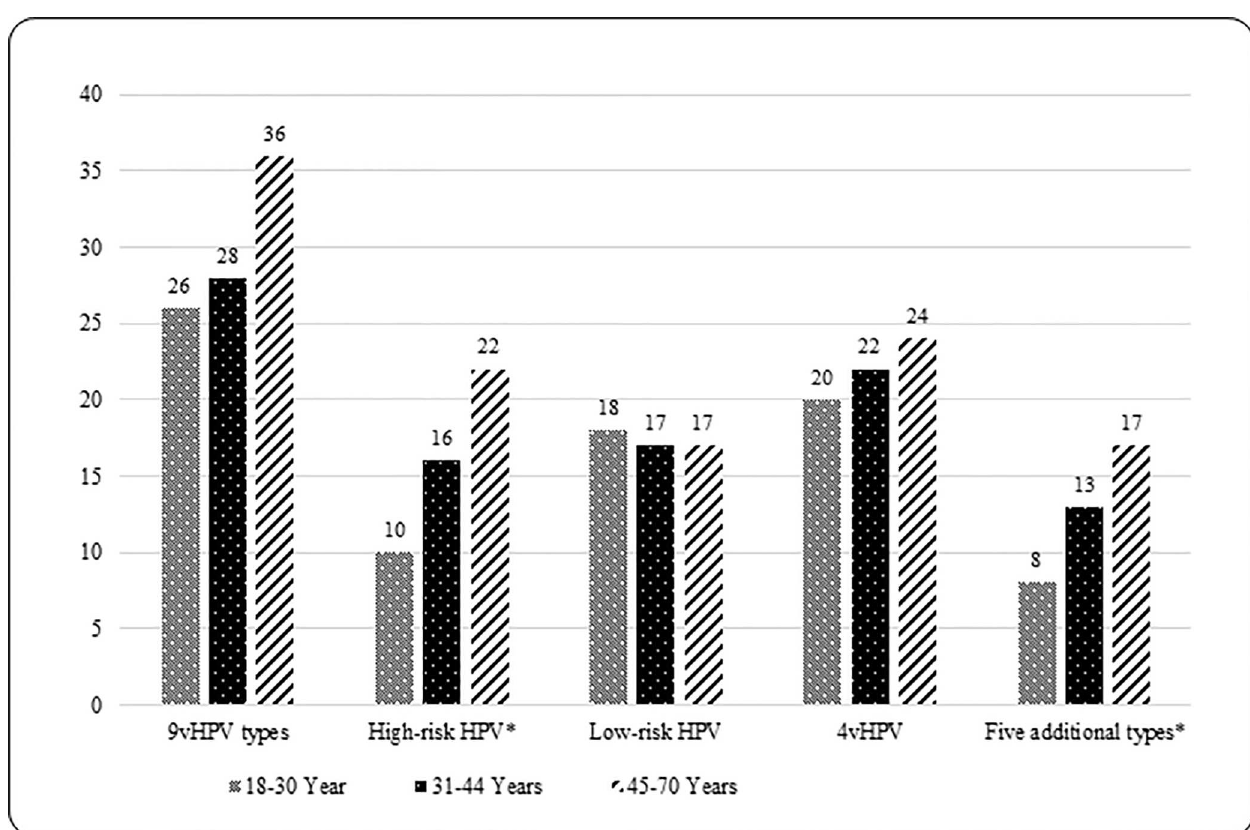
Fig 1. Grouped HPV seroprevalence of nine vaccine types by age group. 9vHPV category includednine vaccine types (6, 11, 16, 18, 31, 33, 45, 52, and 58). ‘9vHPV’variablewas created, if a man was positive for one or more of the nine vaccine types then the ‘9vHPV’variable was seropositive otherwiseseronegative. 4vHPV category includedseropositivity to at least one of the four types of HPV (6, 11, 16 and 18). High-risk 9vHPV category includedseropositivity to at least one of the seven types of HPV (16, 18, 31, 33, 45, 52 and 58). Low-risk 9vHPV category includedseropositivity to at least one of the two types of HPV (6 and 11). Significant p-value < 0.05 is marked with ‘ * ’. P-value was obtainedfrom Cochran-Armitage Trend Test. P trend < 0.05 for high-riskand five additionaltypes